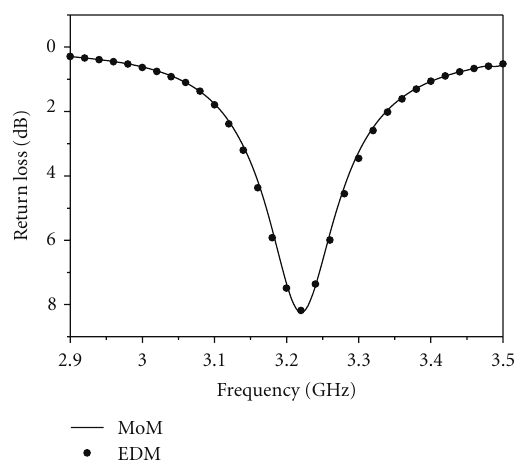
Figure 6: Ruturn loss as a function of